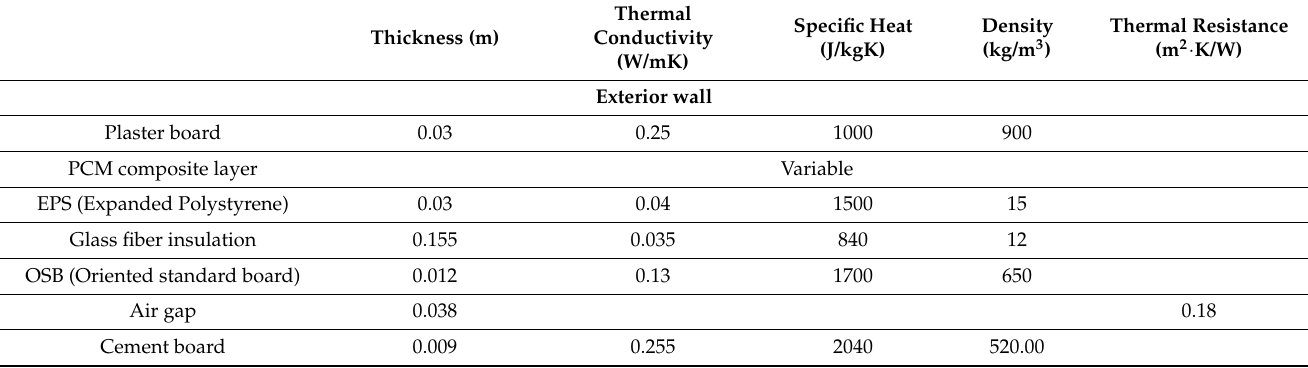
Table 2. Material properties and constructions of the modeled exterior wall, partition, and